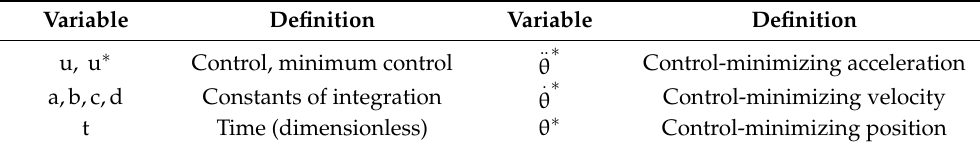
Table 4. Proximal variable definitions 1